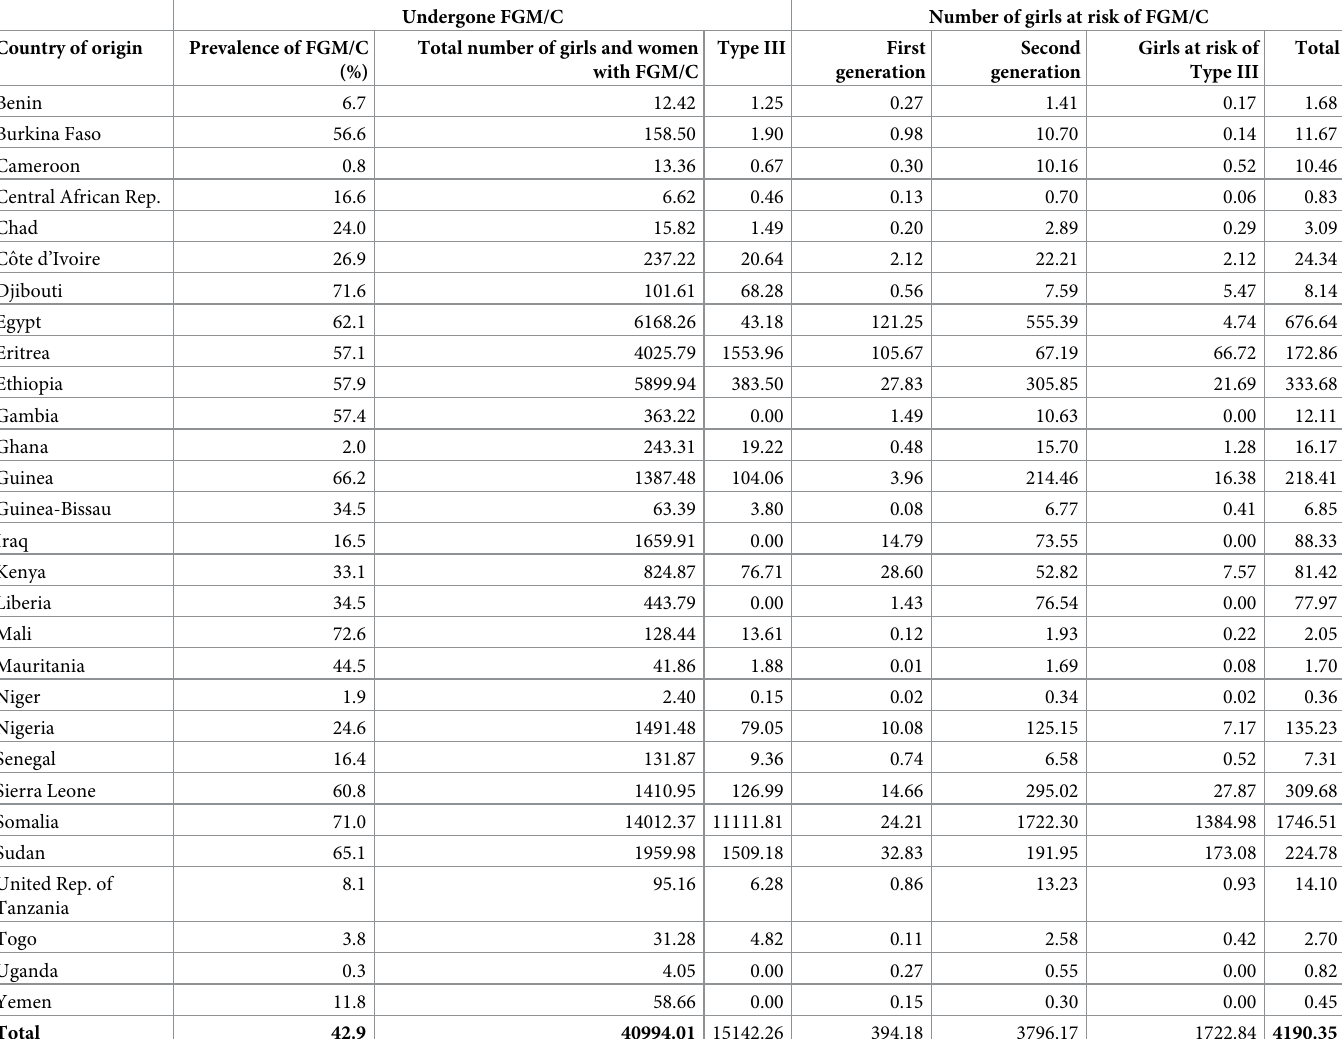
Table 2. Estimated numbers of girls and women already undergone FGM/C by Type III, and estimated number of girls at risk of